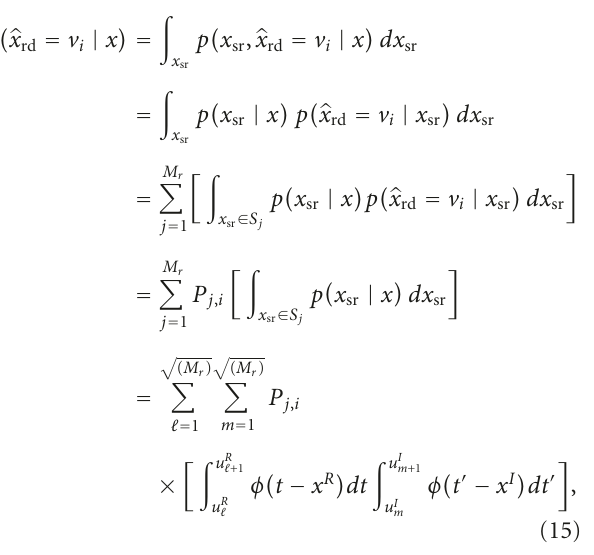
for the real part k , (cid:3)